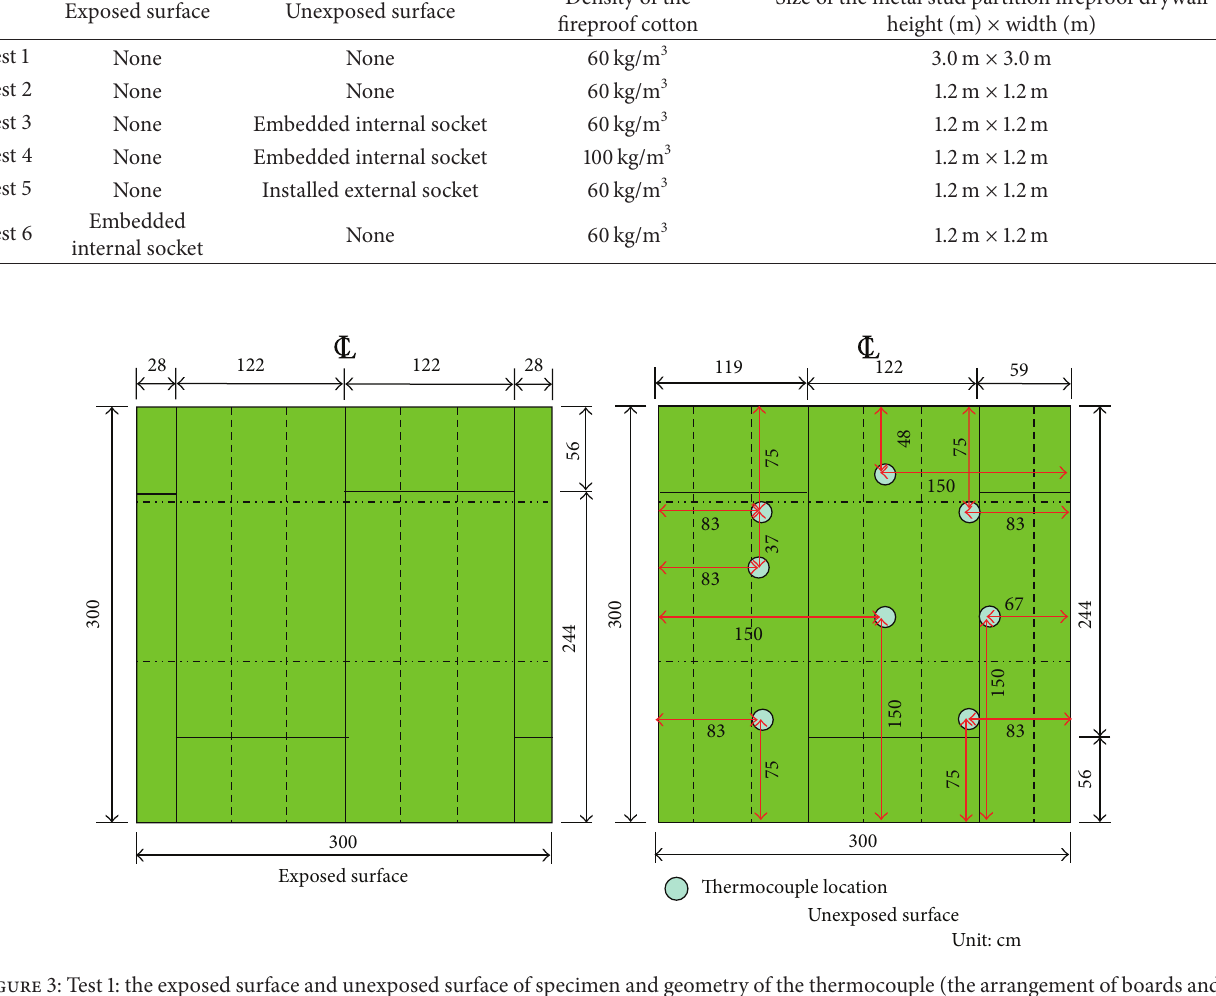
Figure 3: Test 1: the exposed surface and unexposed surface of specimen and geometry of the thermocouple (the arrangement of boards and measuring points of